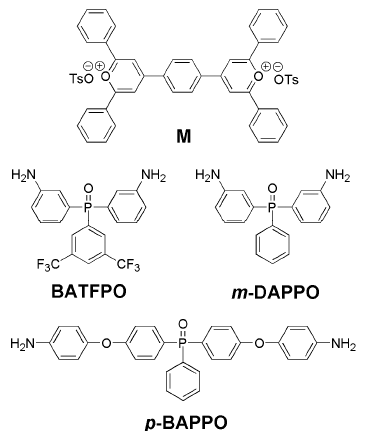
Figure 2. Chemical structures of 4,4 ′ -(1,4-phenylene)-bis(2,6-diphenylpyrylium) ditosylate monomer ( M ), and phosphine oxide containing diamines, bis(3-aminophenyl)phenyl phosphine oxide ( m-DAPPO ), bis(3-aminophenyl)-3,5-bis(trifluoromethyl)phenyl phosphine oxide ( BATFPO ), and bis(4-aminophenoxy-4-phenyl) phenyl phosphine oxide ( p-BAPPO ).